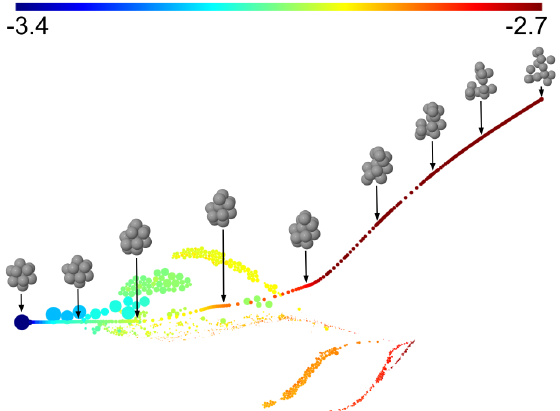
FIG. 5. 2D SHEAP map produced from a dataset consisting of local minima on the LJ 13 PES, plus selected structures visited along the pathway of steepest descent from an unrelaxed structure generated without symmetry constraint, down to the global mini- mum. Structures are described by sorted lists of all pairwise dis- tances. The projection uses a perplexity of 30. Circles are colored according to energy per atom in Lennard-Jones units, given by the color bar at the top of the figure. For the minima, basin volumes are represented by the area of each circle, with a mini- mum hard-sphere radius R 0 ¼ 0 . 005 . Circles representing struc- tures visited during the relaxation are enlarged to highlight